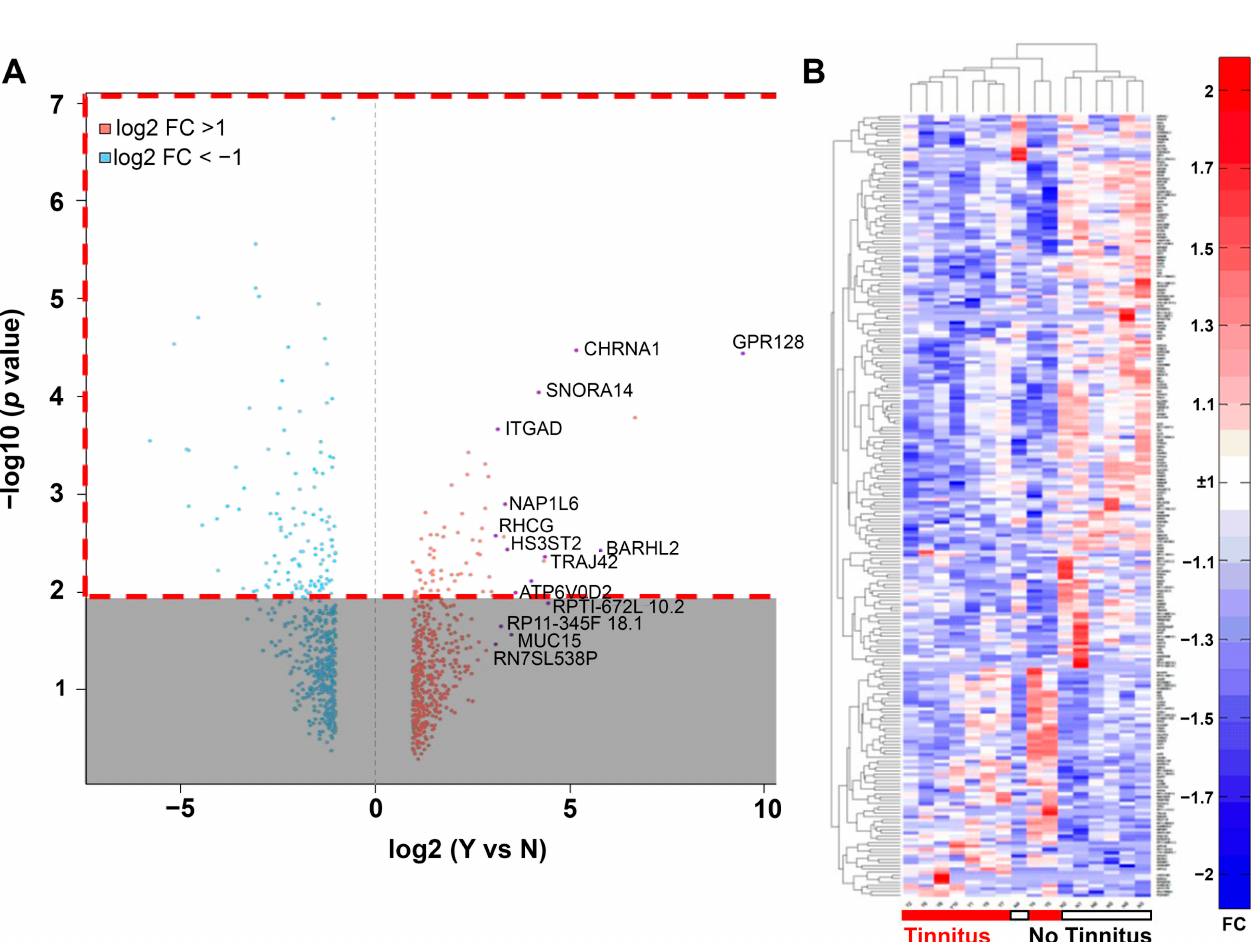
Figure 3. Bioinformatic analysis of genes that were differentially expressed in VS samples stratified by the presence or absence of associated tinnitus. ( A ) Volcano plot highlighting differentially expressed genes associated with tinnitus (n = 9 [VS samples]) vs. no tinnitus (n = 7). Transcripts with >2-fold change in expression are shown as red (up-regulated) and blue dots (down-regulated). The dashed red box highlights genes that were selected for the heatmap. ( B ) Heatmap of RNA-seq gene expression levels (log2 of RPKM) compared between patients with and without tinnitus. A total of 179 differentially expressed genes were detected based on the cutoffs of >2-fold change and p -value < 0.01. The heatmap is clustered hierarchically by both samples (columns) and genes (rows). Red indicates differentially higher and blue indicates differentially lower levels of gene expression between groups. Abbreviations: RNA-seq, RNA sequencing; VS, vestibular schwannoma.